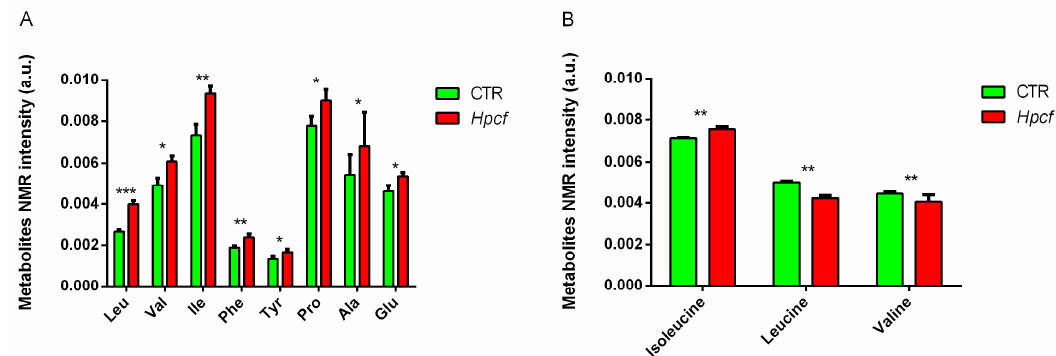
Figure 1. ( A ) Intracellular amino acid concentration differentiation (leucine, valine, isoleucine, phenylalanine, tyrosine, proline and alanine) detected in MKN-28 cells incubated (red columns) or not incubated (green columns) with Hpcf . ( B ) Extracellular branched chain amino acids (BCAAs) (leucine, isoleucine, and valine) concentration differences detected in culture medium of MKN-28 cells incubated (red columns) or not incubated (green columns) with Hpcf . Some Hp strains synthesize isoleucine, including ours, which explains the upregulation of isoleucine. The X-axis lists single amino acids, and the Y-axis reports the differences in individual amino acids scaled to the total NMR spectral area. Intensity of amino acids is expressed in arbitrary units and represented as means ± SD (* p < 0.5; ** p < 0.01; *** p < 0.001) calculated from two experiments, each carried out in quadruplicate (Reprinted with permission from ref. [14]. Copyright 2021, Domenico Ian- nelli).